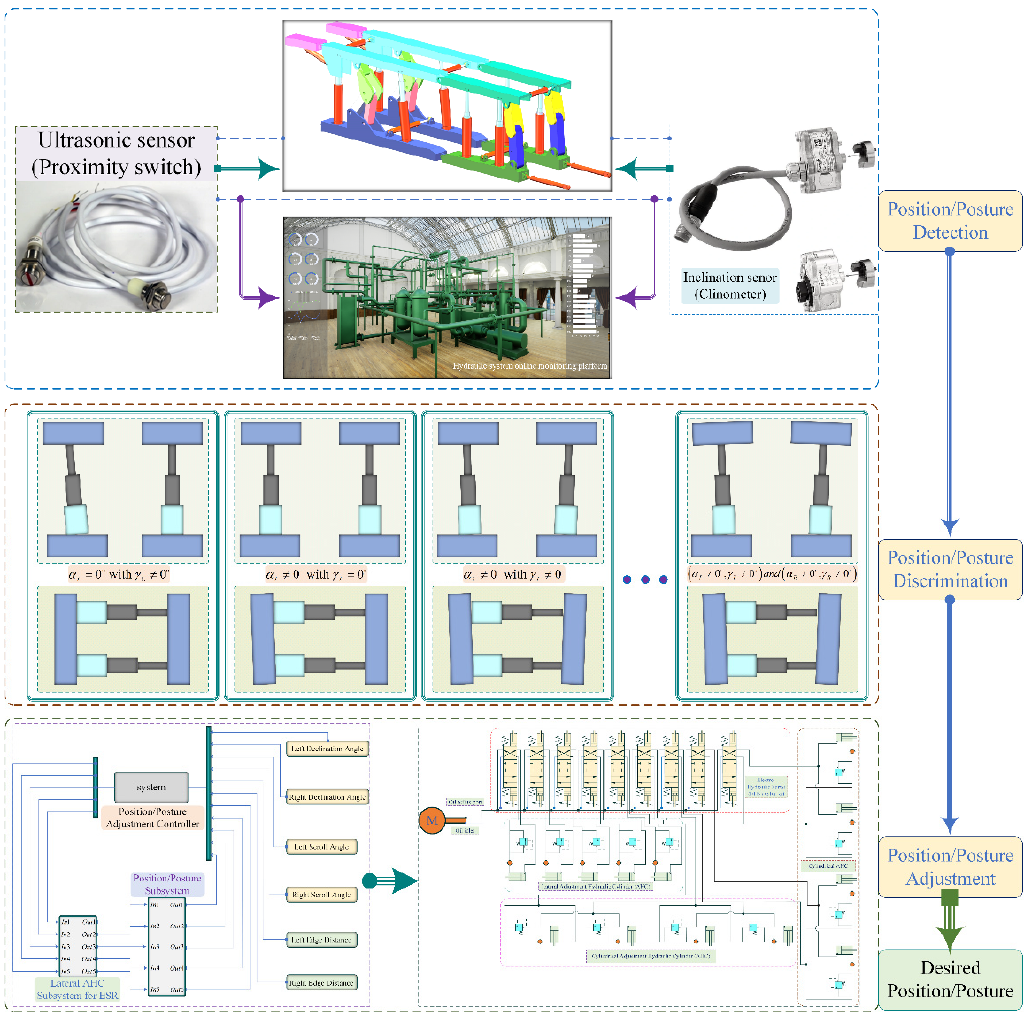
Figure 8. The general configuration of desired position/posture adjustment control system for ESR.